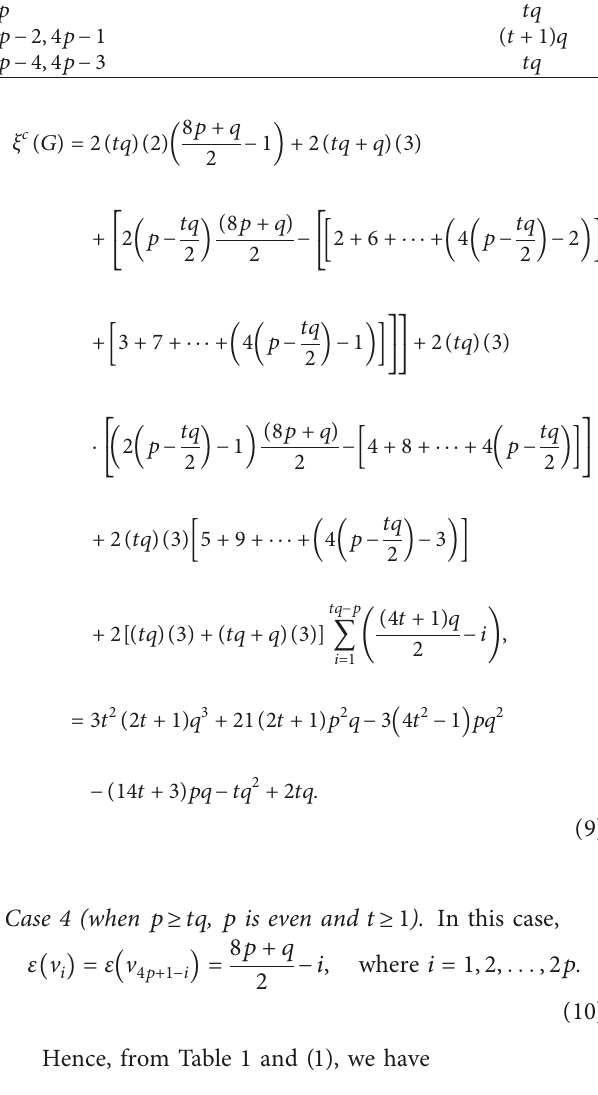
Table 1: The vertex partitions of the P t Vertex partition Rows V 1 1